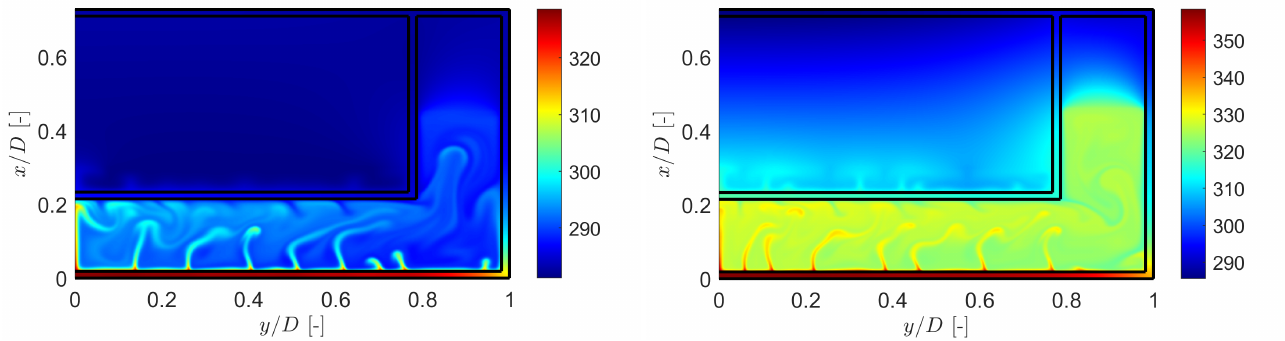
Figure 8. Temperature profile in the cooker in the initial stage of heating. ( Left ) t = 330 s and ( Right ) t = 1404